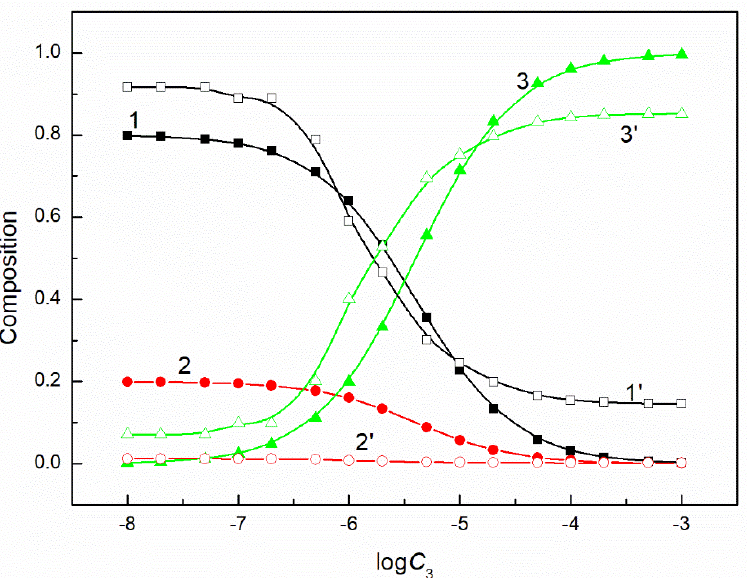
Figure 7. A plot of the composition of the ternary mixture including CTAB, TX100 and FC2 in the monolayer (curves 1–3) and in the bulk phase (curves 1’–3’) at the constant C 12 and γ LV = 60 mN/m vs. the logarithm of the FC2 concentration ( logC 3 ). Curves 1, 1’ correspond to CTAB, curves 2, 2’ correspond to TX100 and curves 3–3’ to FC2.